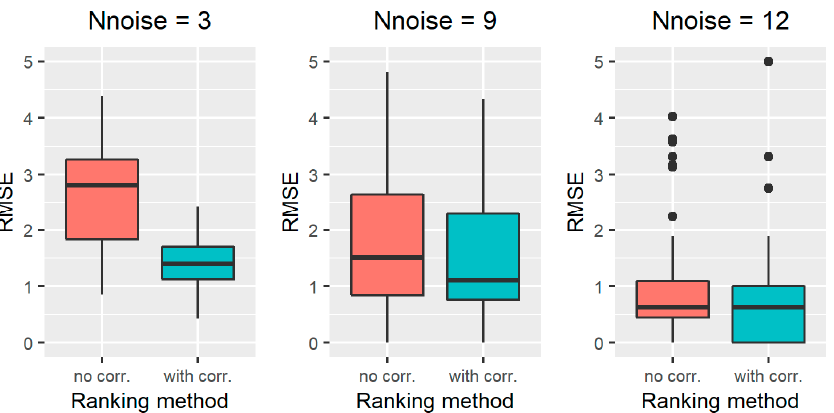
Figure 3. RMSE results obtained for the standard RFE-Borda count method (red boxplot, “no corr.” label) and the proposed algorithm (green boxplot, “with corr.” label) for scenarios 4–6, characterized by a number of noise variables equal to 3 ( left ), 9 ( middle ), and 12 ( right ).